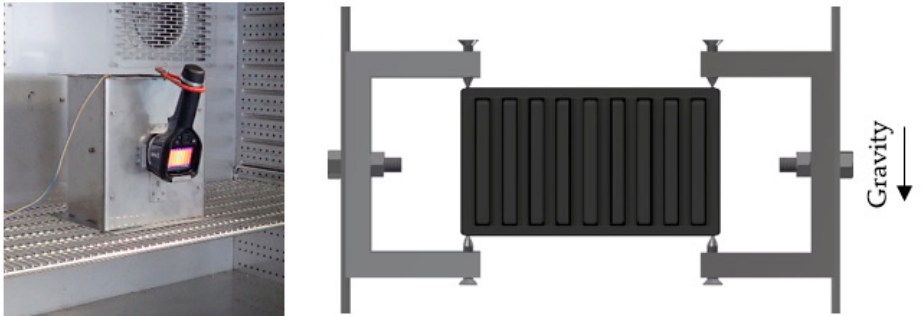
Figure 3. Measurement box inside the thermostatic chamber ( left ), heat sink placement inside the measurement box ( right ).